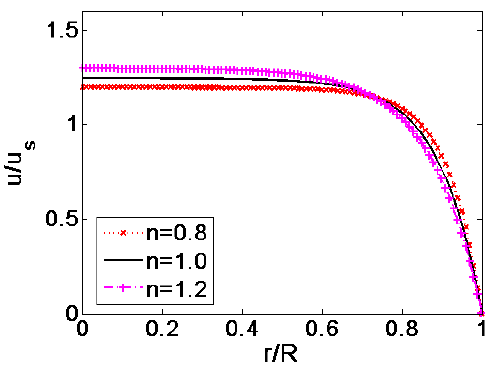
Figure 3. Comparison of the velocity profiles generalized by their respective average velocity at different flow behavior index n ( K = 10, ζ = − 0.1 V).